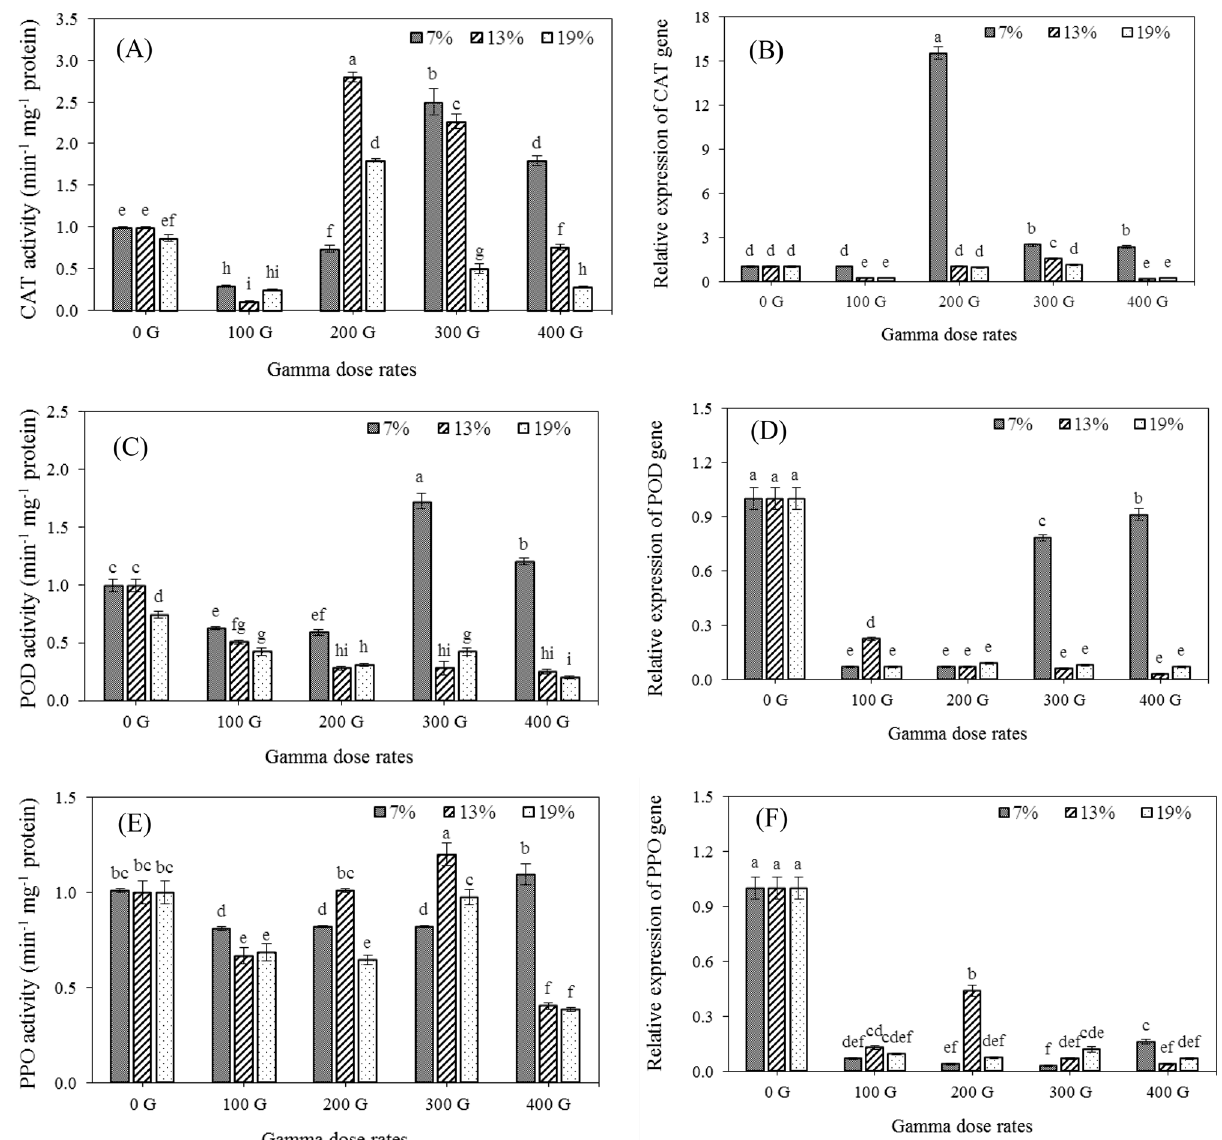
Figure 3. Effects of gamma dose rates and different seed moisture contents on catalase activity ( A ), relative expression of catalase gene ( B ), peroxidase activity ( C ), relative expression of peroxidase gene ( D ), polyphenol oxidase activity ( E ), relative expression of polyphenol oxidase gene ( F ). Each bar represents mean ± SE (n = 3). Mean values marked with different letters are significantly different (p ≤ 0.05) by LSD